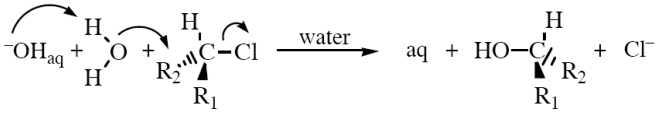
SN2 substitution of a secondary alkyl halide by hydroxide ion.